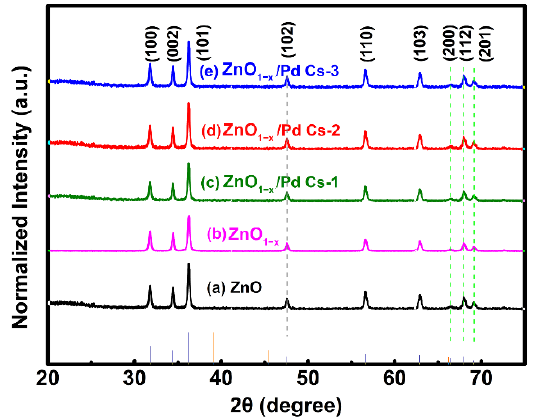
Figure 1. XRD patterns of several nanomaterials (( a ) ZnO, ( b ) ZnO 1−x , ( c ) Pd Cs-1/ ZnO 1−x , ( d ) Pd Cs-2/ZnO 1−x , ( e ) Pd Cs-3/ZnO 1−x , respectively). Table 1. Details of ZnO XRD characterization information.